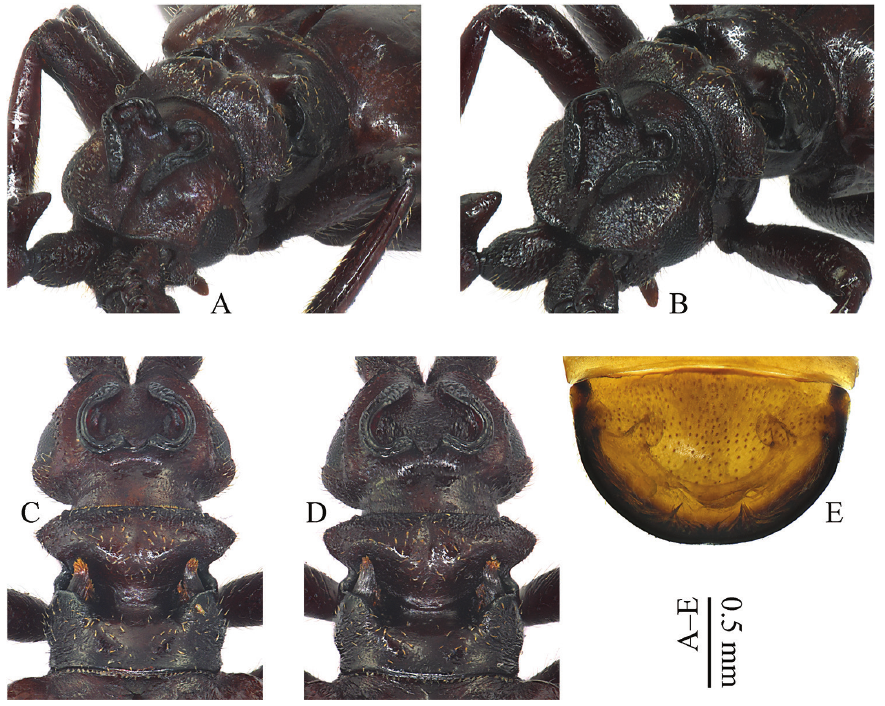
Figure 3. Paussus ( Scaphipaussus ) zhouchaoi sp. n. ( A, C, E holotype, ♂ B, D paratype, ♀ ). A–D heads